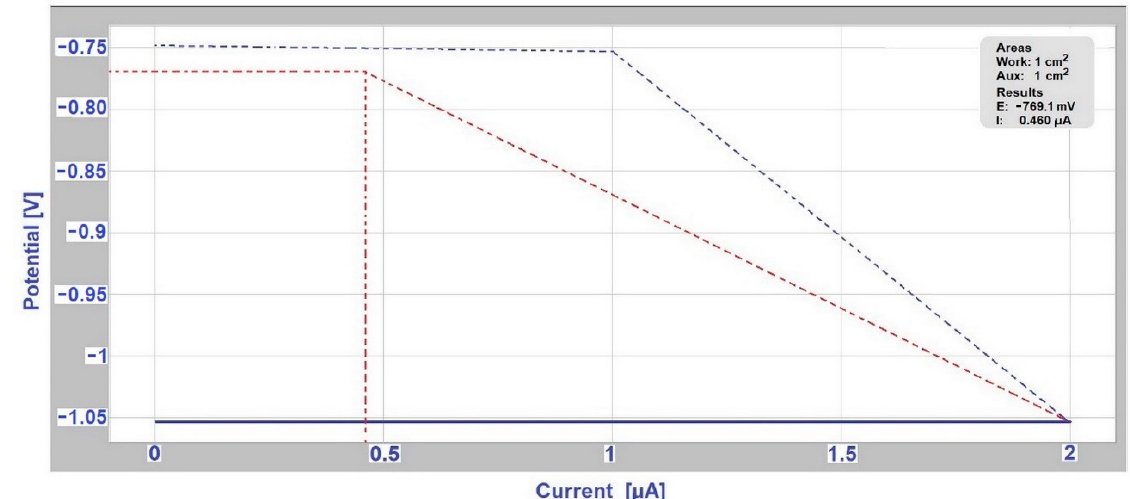
Figure 7. Evans diagram for hot-dip galvanized steel/EN AW-6060 couple (ratio of anode A and cathode A:C is 1:1) in deicing salt in the fourth week of measurement.